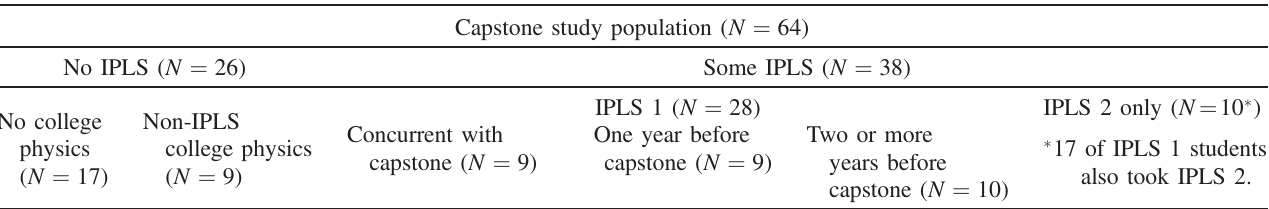
TABLE III. Physics backgrounds of students in the capstone study. Students in the capstone course either took no IPLS physics or took at least some IPLS physics. Among those who did not take IPLS physics, some took no college physics and some took non-IPLS college physics. Among those who did take at least some IPLS physics, some took only one semester of IPLS and others took two. The students who took IPLS 1 did so at different time points relative to their enrollment in the capstone